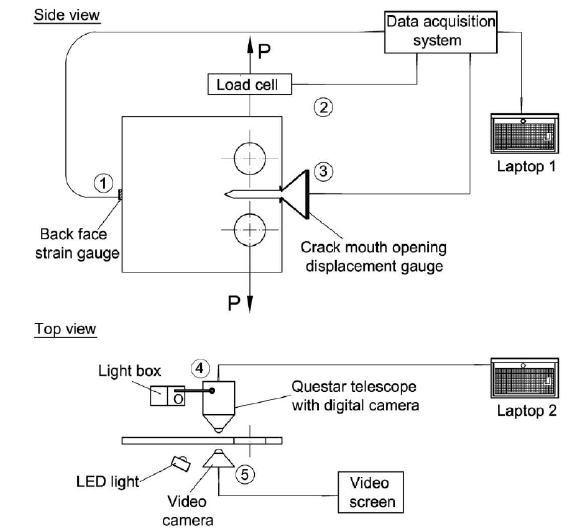
Figure 1: Experimental configuration: side and top